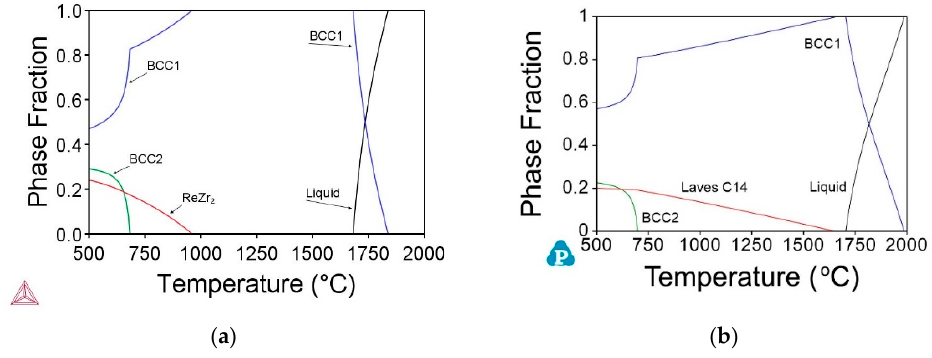
Figure 15. Equilibrium phase diagrams of Re 0.3 NbTiZr calculated using the ( a ) TCHEA4.1 database and ( b ) PanNb2020 database.